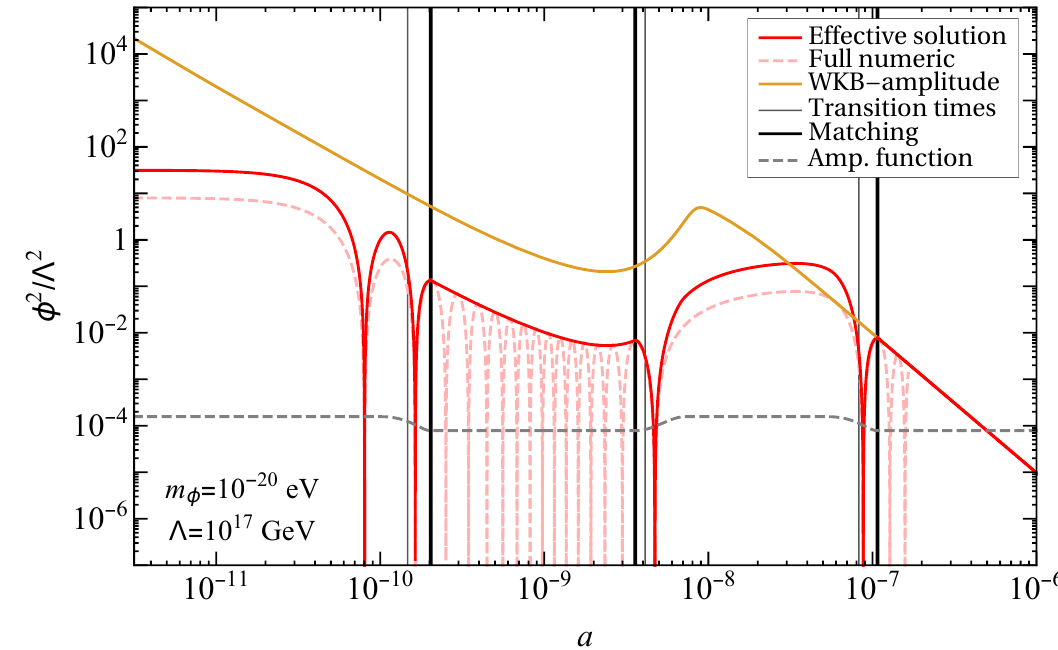
Figure 6 : Same as figure 2 (right), but with transition times marked with vertical lines and the amplification function visualized by the red dashed line. The amplification function (gray, dashed), which takes values in the range between 1 and 2, is shown here with an artificial amplitude for visualization. The effective solution (red, solid) is the patching between the full numeric solution (red, dashed) and the WKB-amplitude (orange, solid) for the rapidly-oscillating